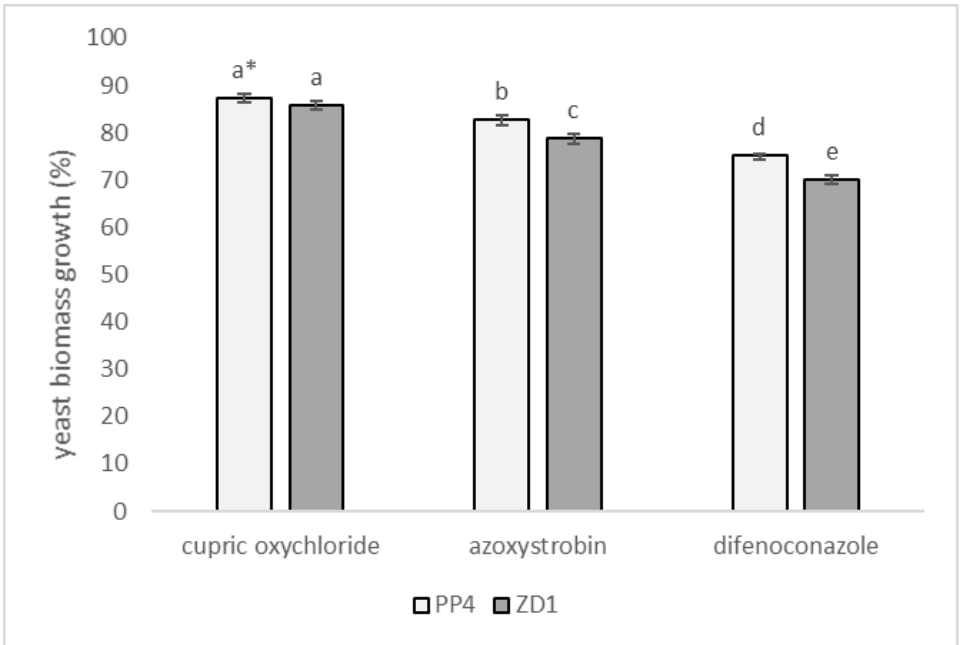
Figure 4. The influence of fungicides on the biomass production of the yeasts A. pullulans PP4 and A. pullulans ZD1; The maximum biomass production (100% growth) was taken as the biomass yield of the control trials; * values marked with the same letters do not differ significantly at p < 0.05 (Tukey’s post hoc test); and error bars represent the standard deviation.